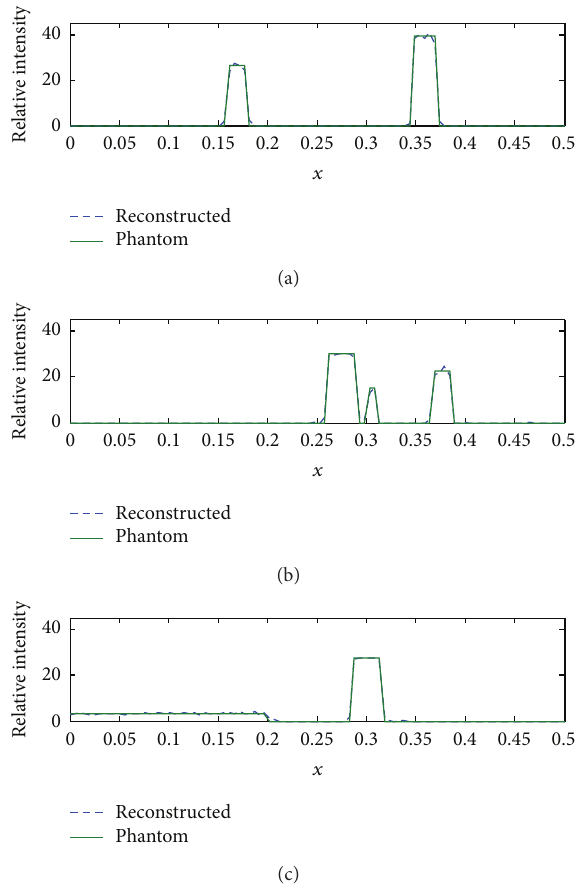
Figure 4: Comparison of relative intensity distributions of the phantom object and the reconstructed result at three different relative heights of 0.25, 0.50, and 0.75 from the bottom to the top (the axis “ x ” represents the relative distance to the left boundary of the